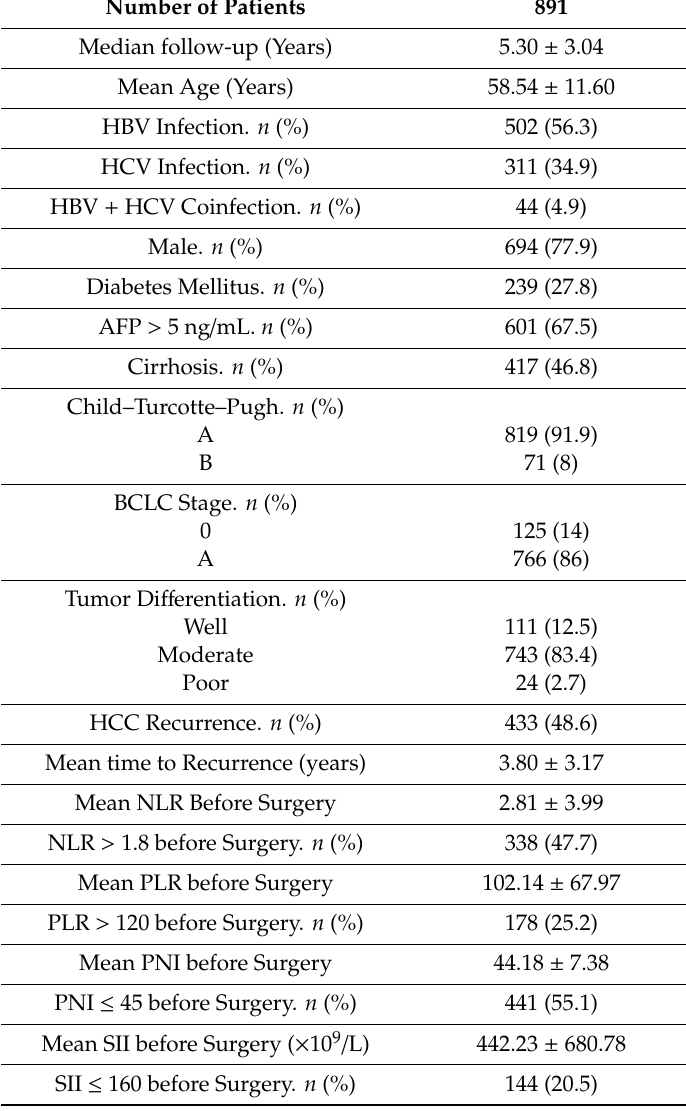
Table 1. Patients’ baseline characteristics before